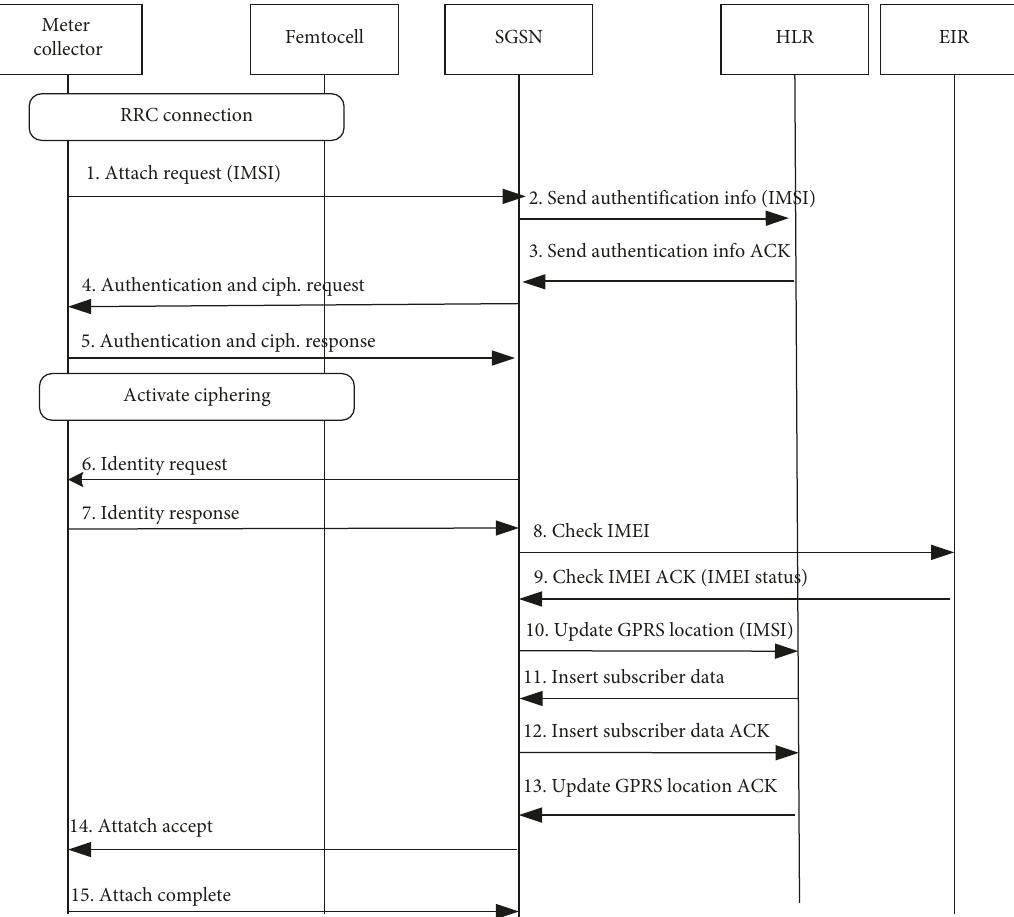
Figure 2: Attach process of a meter collector.